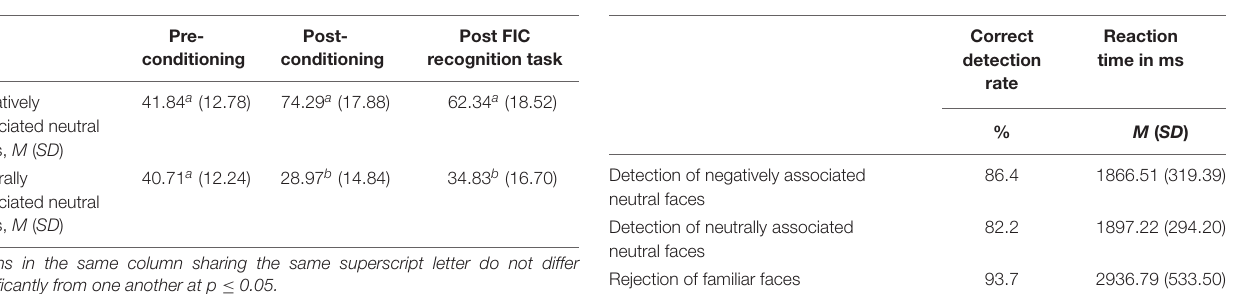
TABLE 4 | Mean RTs in milliseconds and standard deviations of the FIC recognition task ( N = 67).